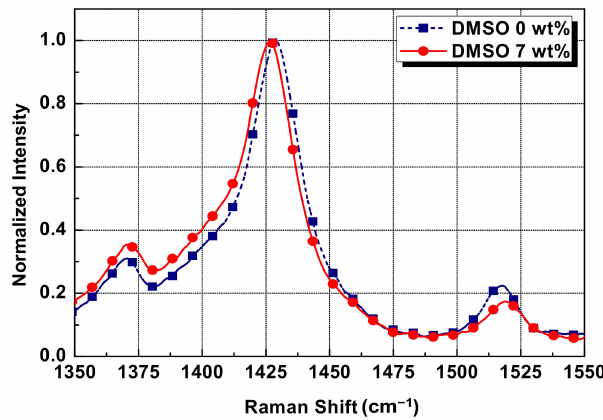
Figure 4. Raman spectra of pristine film and film with 7 wt% DMSO